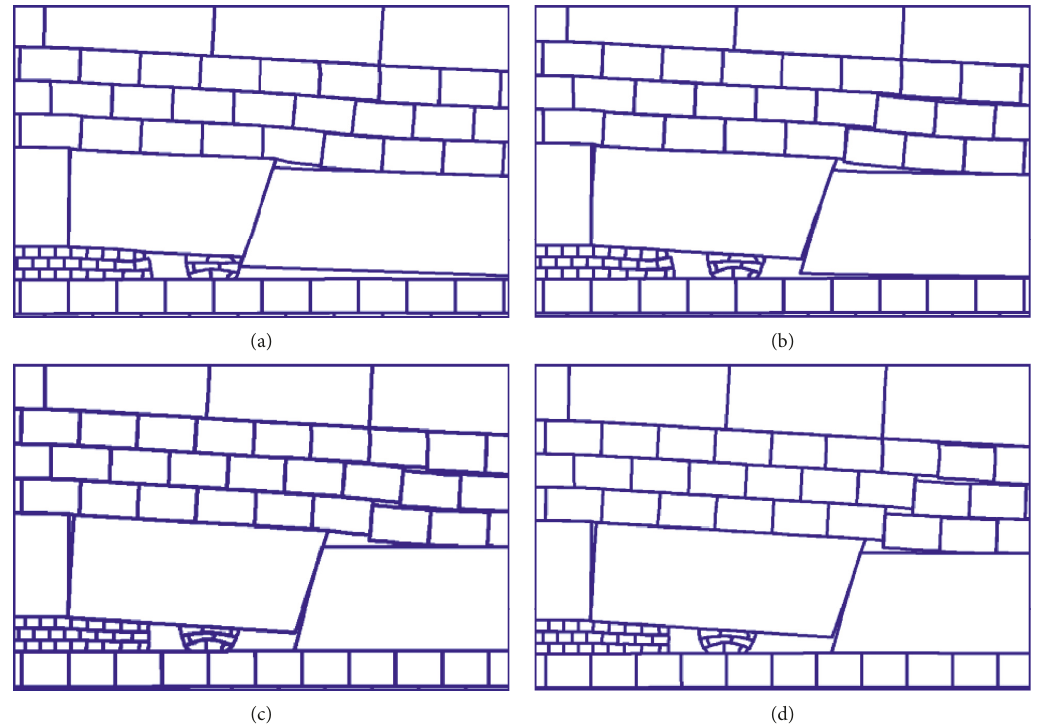
Figure 9: Variations of roof structure with different cutting positions: (a) 1m, (b) 3m, (c) 5m, and (d) 7m.